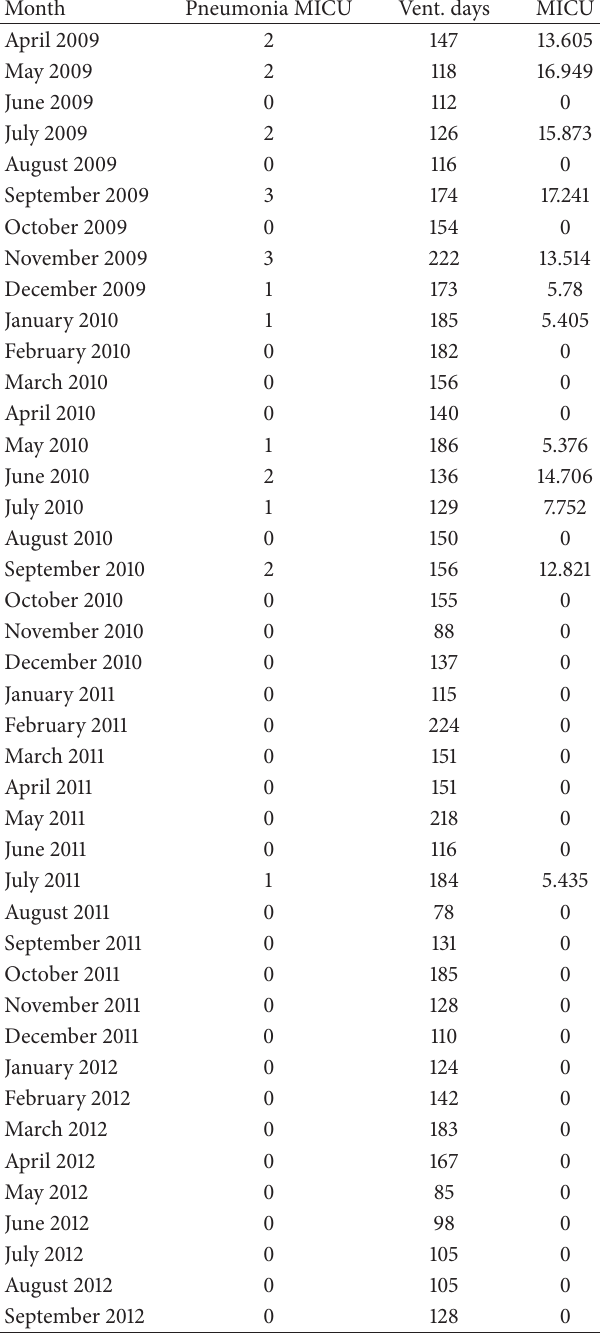
Table 1: Monthly ventilator-associated pneumonia rate from